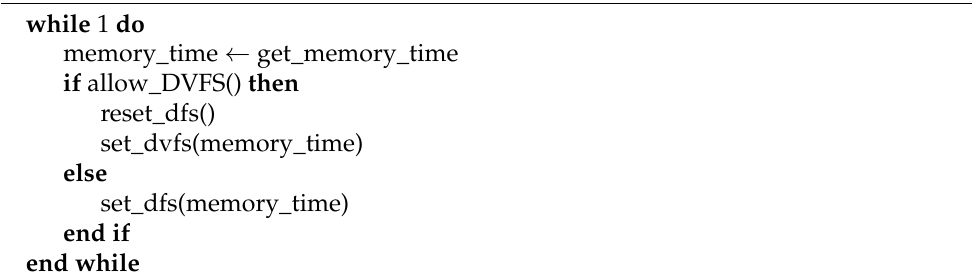
Algorithm 2 Power management firmware via dense